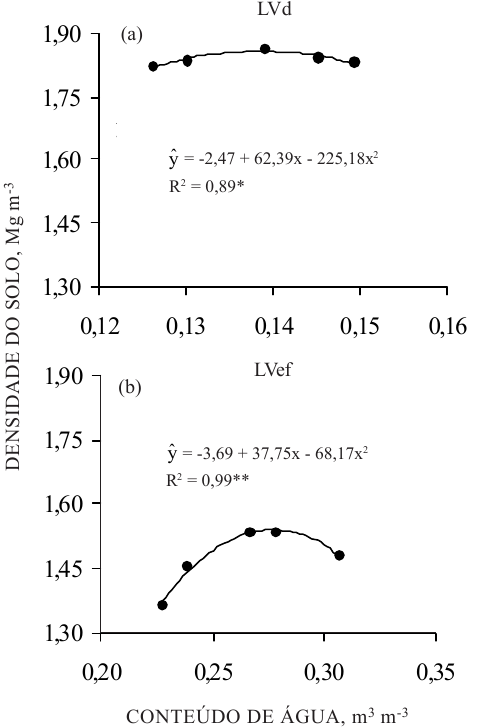
Figura 1. Densidade máxima determinada com o aparelho de Proctor, no (a) Latossolo Vermelho textura média (LVd) e (b) argilosa (LVef). **, * Significativos a 1 e 5 %, respectivamente.